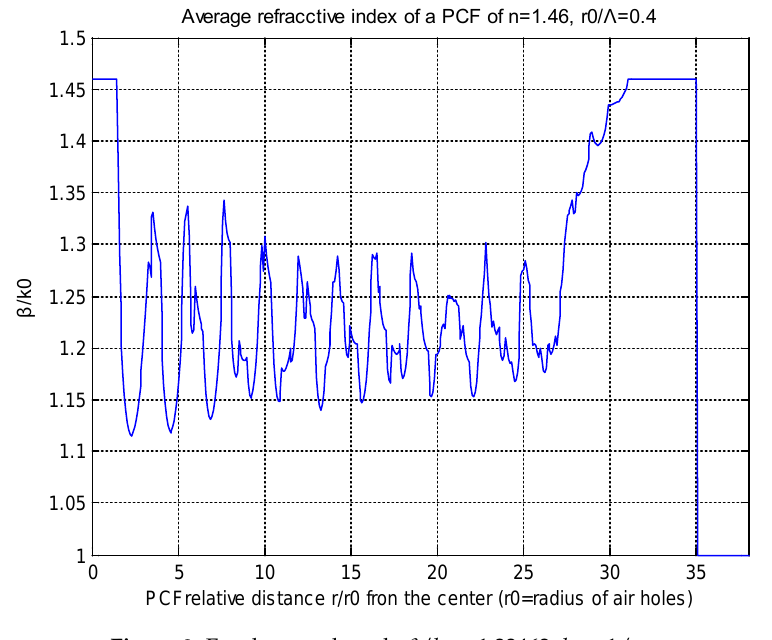
Appl. Sci. 2019 , 9 , x Figure 9. Fundamental mode β / k 0 = 1.22462, k 0 = 1/ r 0 . Figure 9 Fundamental mode β / k 0 = 1.22462, k 0 = 1/ r 0 .